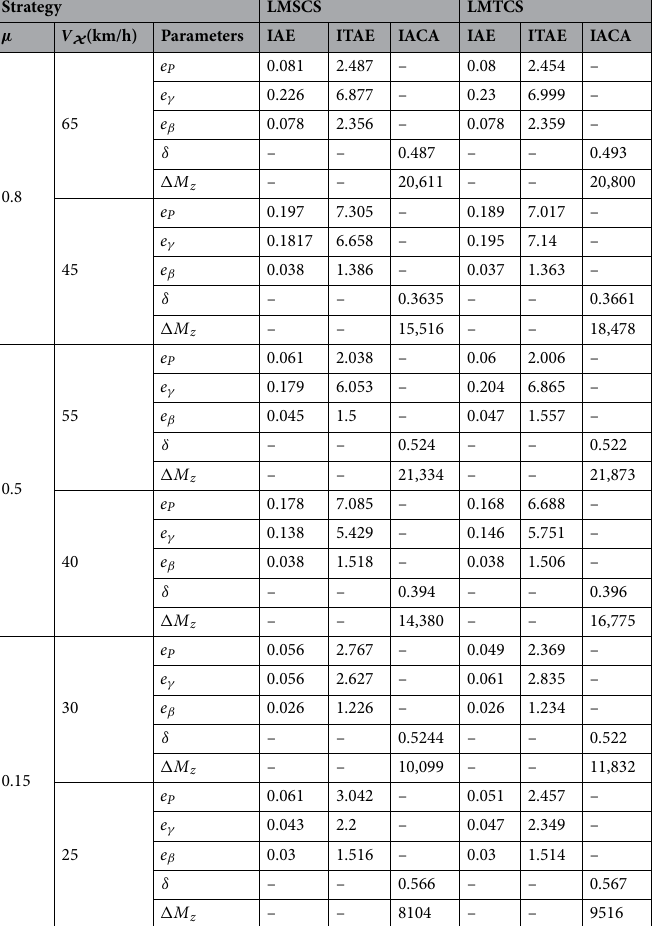
Table 4. Evaluation index statistics of lateral movement